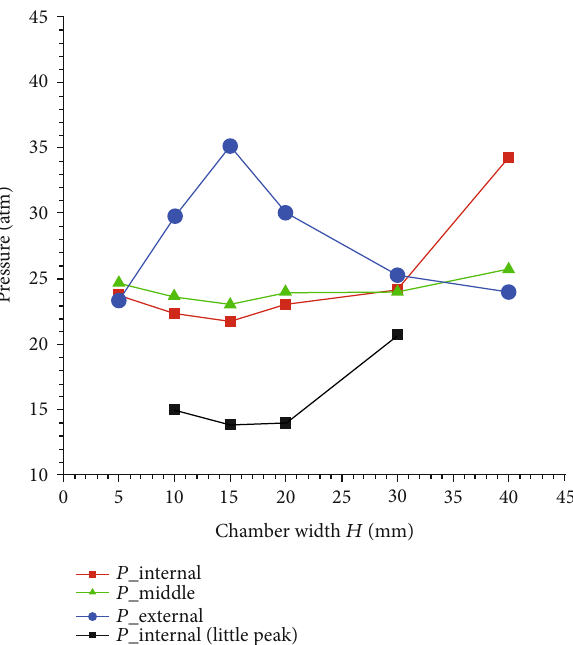
Figure 14: Pressures distribution of di ff erent chambers.